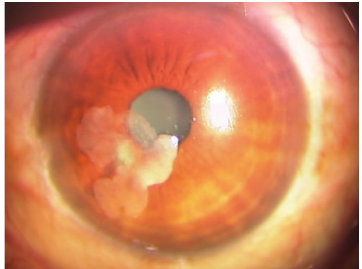
Figure 1: Avascular whitish plaque-like lesion is observed in the cornea.